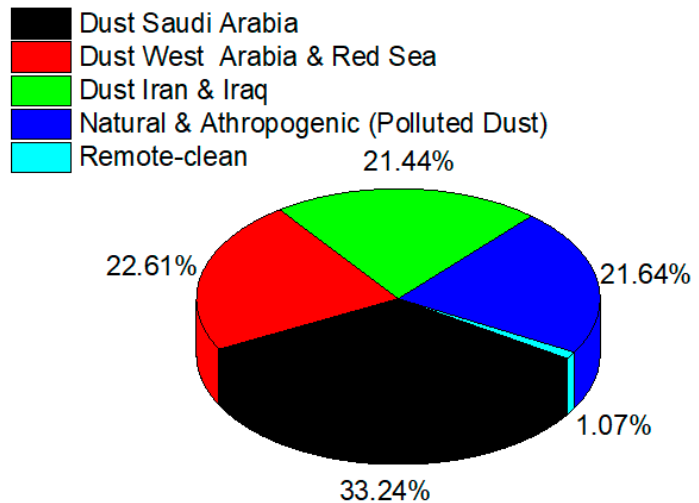
Figure 11. Contribution of the discrete source areas to the statistically mean value of AOD 500 .